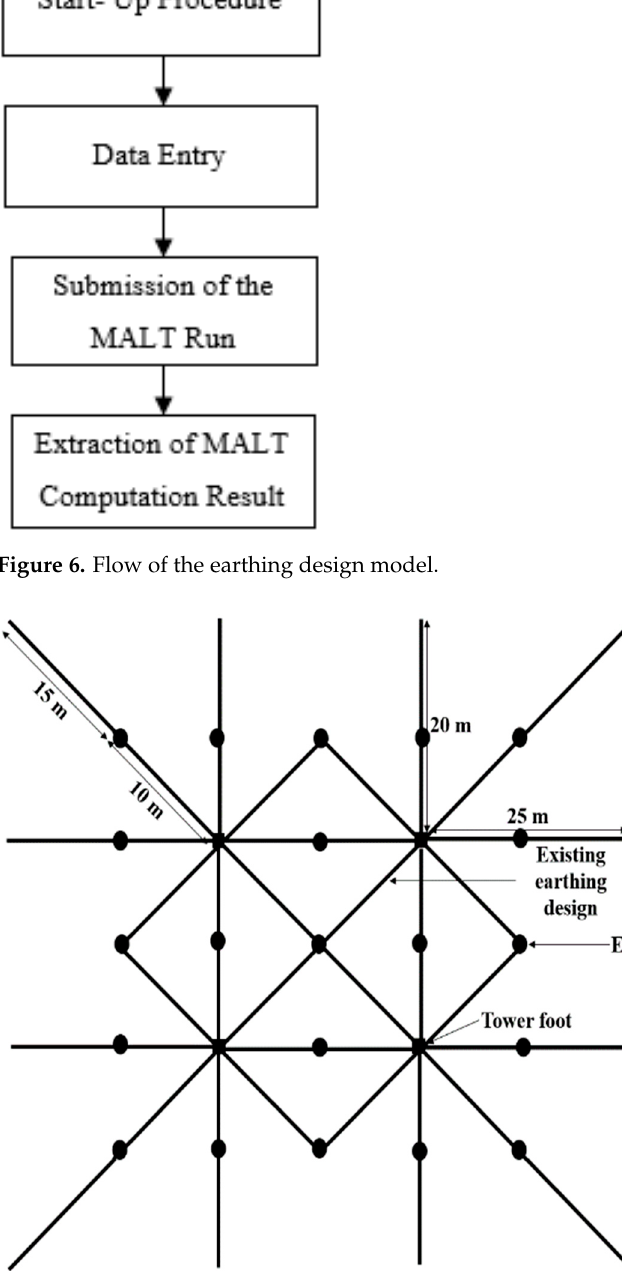
Figure 6. Flow of the earthing design model.